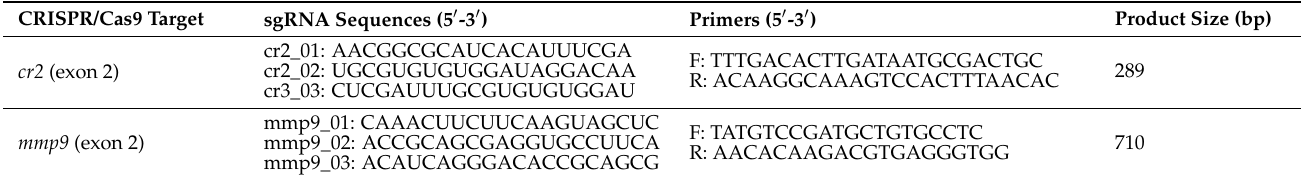
Table 1. Single guide RNA sequences and primers used for amplification and sequencing of target genomic